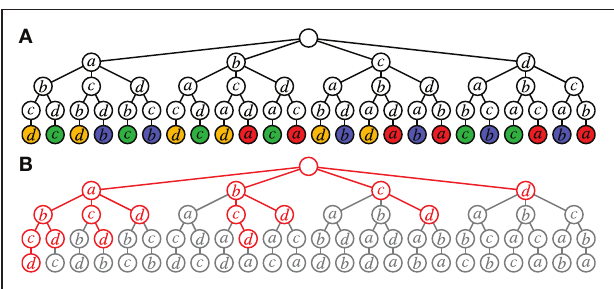
FIGURE 5 | Redundancy in Accretion. (A) Unconstrained search for an assembly of four neurons. In nodes with the same color the same statistical test (leaf against path) is carried out. (B) Accretion search (whole tree) vs. FIM search (red). The red part corresponds to Figure 2B , the red and gray part together to Figure 2A (all possible paths to the set { a , b , c , d } in the Hasse diagram are spelled out in this